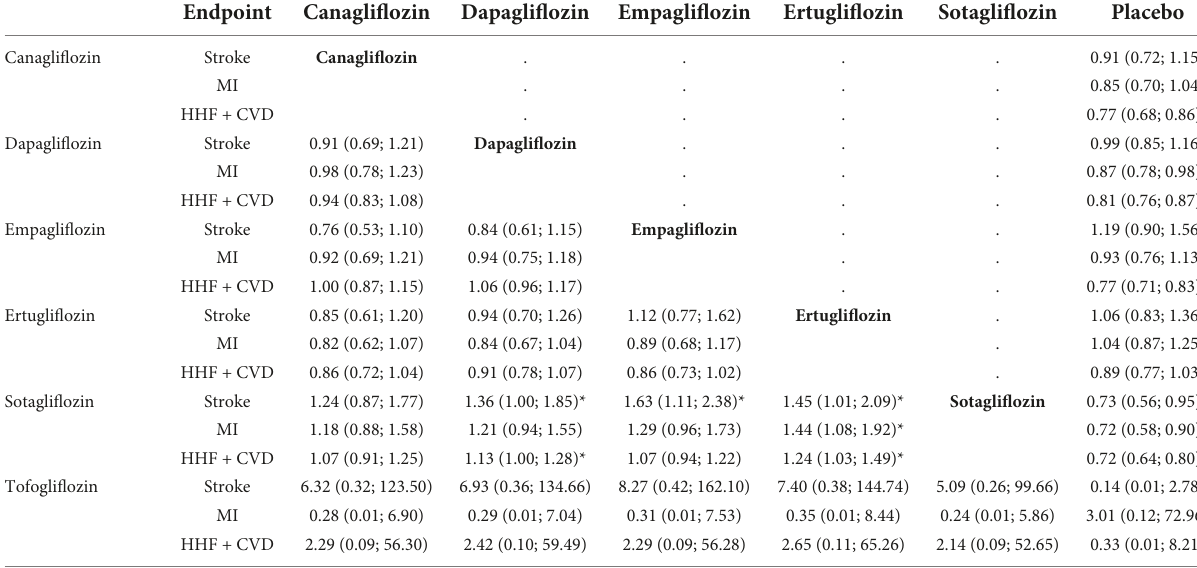
TABLE 2 League table of the indirect gliflozin to gliflozin comparisons. Endpoint Canagliflozin Dapagliflozin Empagliflozin Sotagliflozin